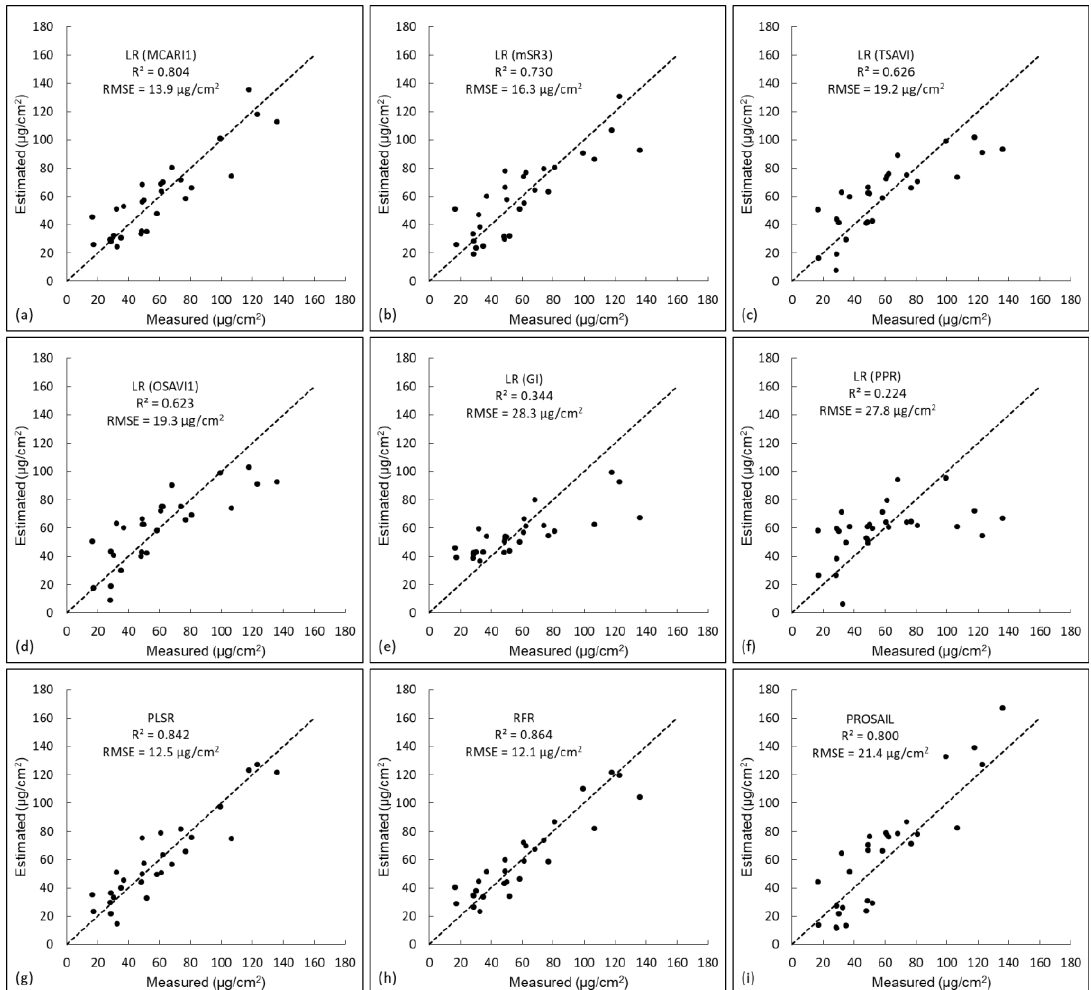
Figure 9. Scatter plots showing measured canopy chlorophyll content versus estimated values from different models built for the June image. Figure ( a ) – ( f ) show LRs built with different VIs and have accuracies from high to low. Figure (g)-(i) show results of PLSR, RFR, and PROSAIL, respectively. P values for all correlations are less than